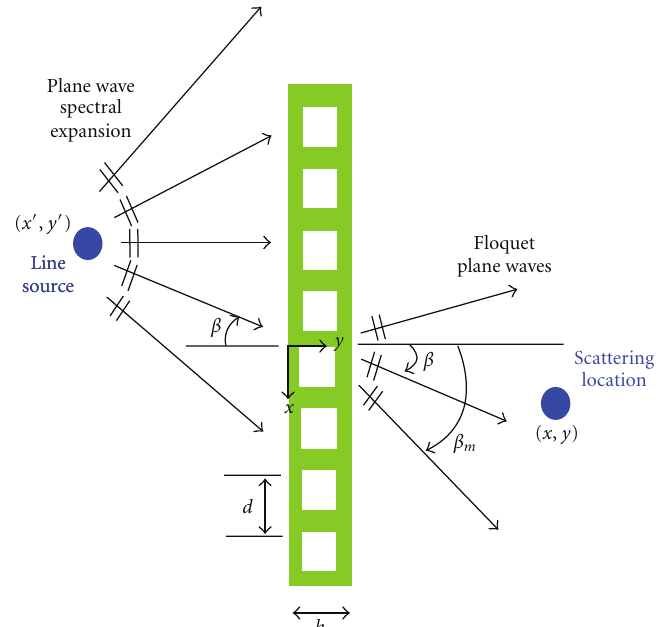
Figure 1: Line source illumination of a periodic wall. Radiated fields from the line source are represented with a plane wave spectral expansion. Each plane wave gives rise to another set of transmitted Floquet plane